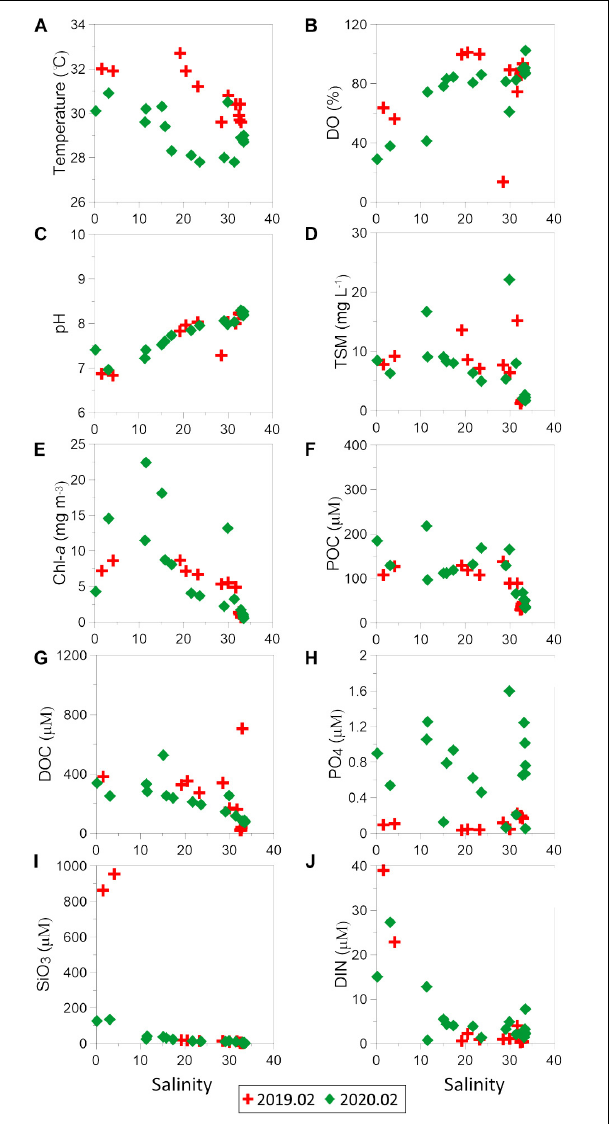
FIGURE 3 | The distribution of (A) surface temperature, (B) DO, (C) pH, (D) TSM, (E) Chl- a , (F) POC, (G) DOC, (H) PO4, (I) SiO3, and (J) DIN along the salinity gradient in dry